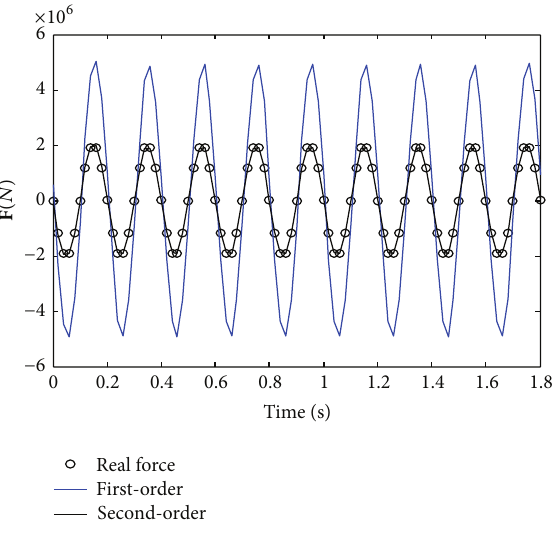
Figure 2: Force identification results of F (𝑡) .